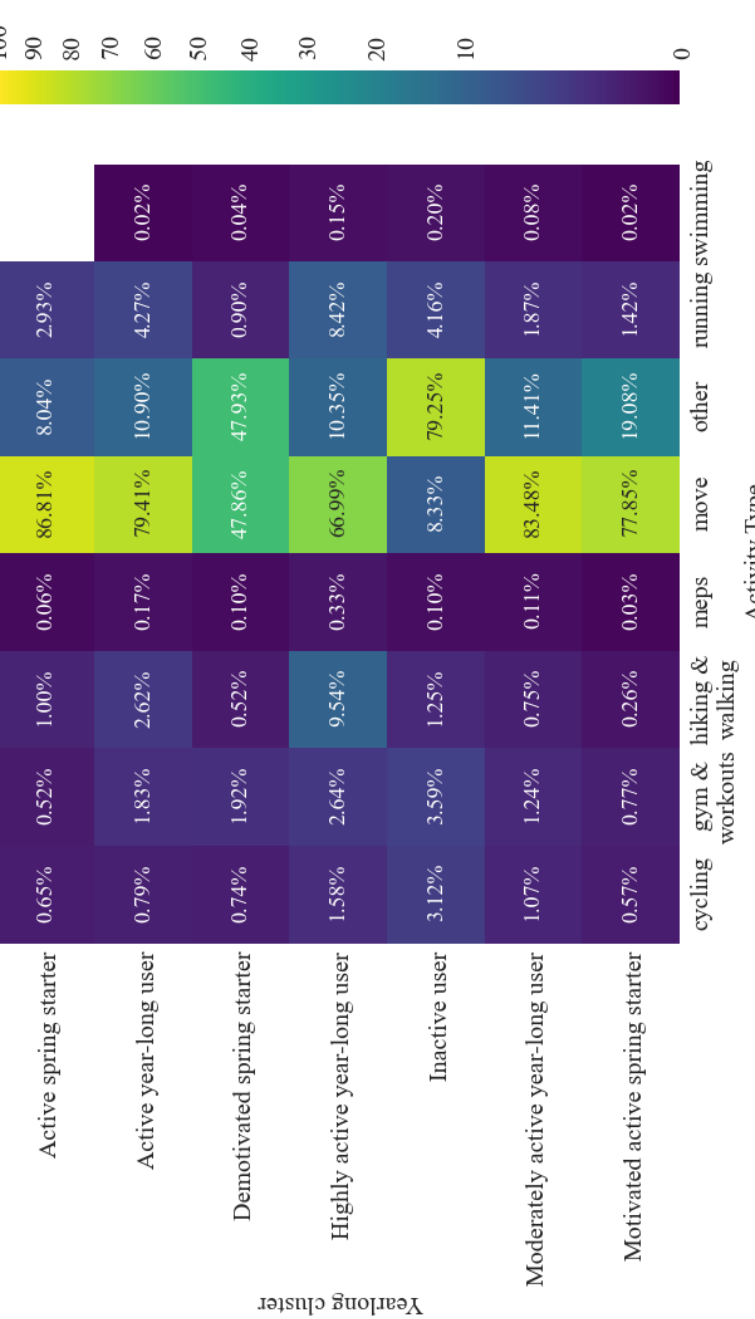
Figure 10. Proportion of activities recorded by each cluster by activity